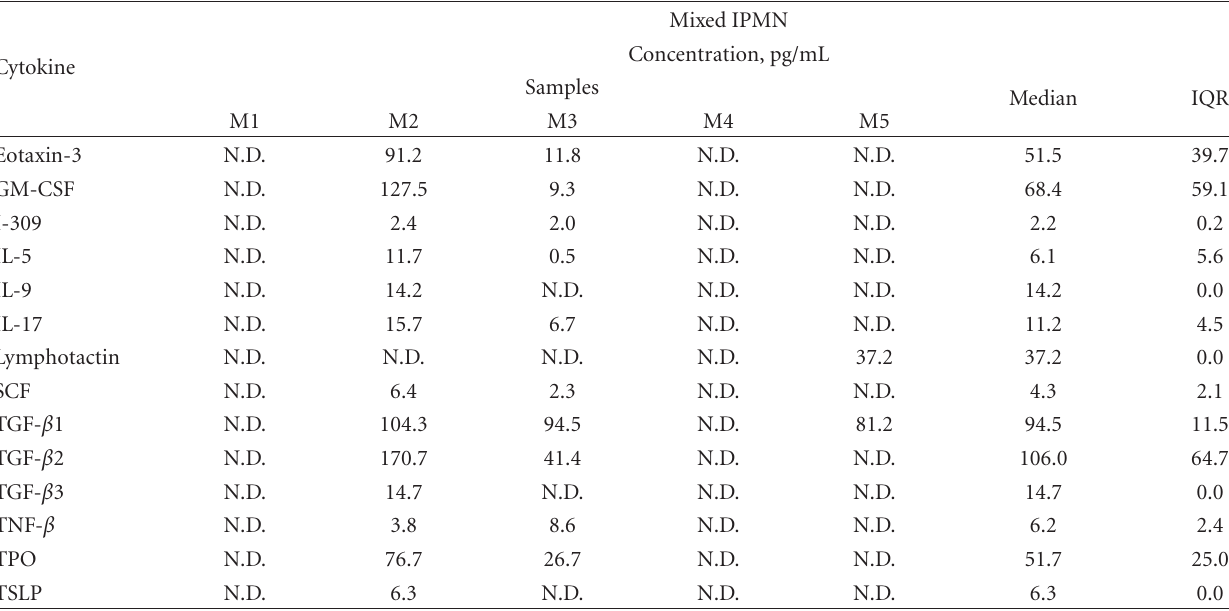
Table 2: Inflammatory mediator proteins ( n = 14) detected only in mixed IPMN.